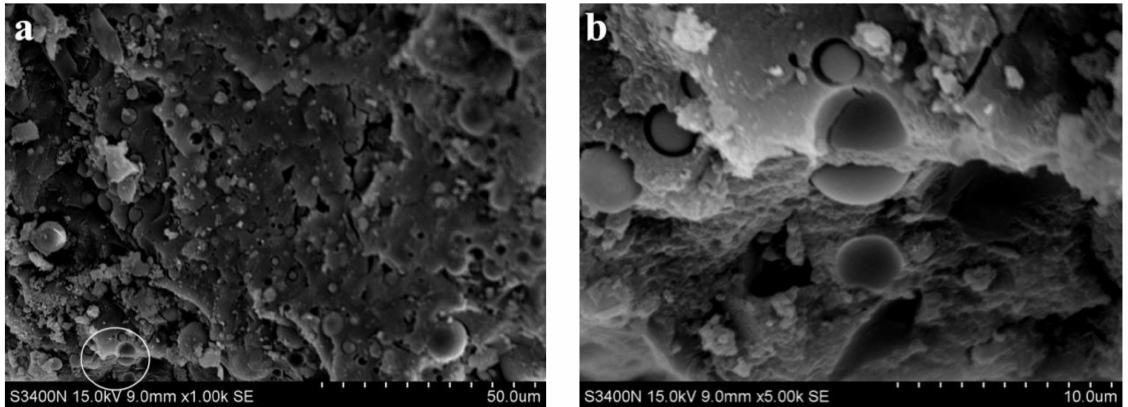
Figure 12. SEM images of alkali slag cement sand replaced by 80% ore powder with fly ash at